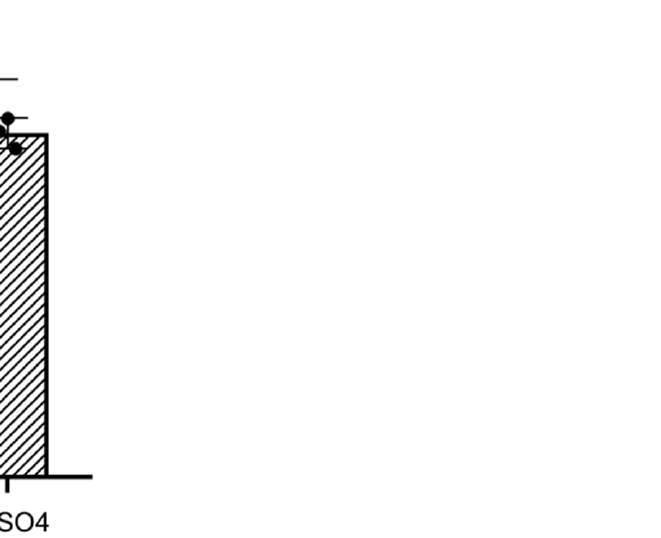
Figure 1. Galanin expression before (CTRL) and after copper sulfate treatment (CuSO 4 ). Galanin is approximately 4 times upregulated after copper sulfate exposure compared to the untreated group. Data and mean ± SEM were pulled from three independent experiments. **** p < 0.0001 (determined using unpaired t test).